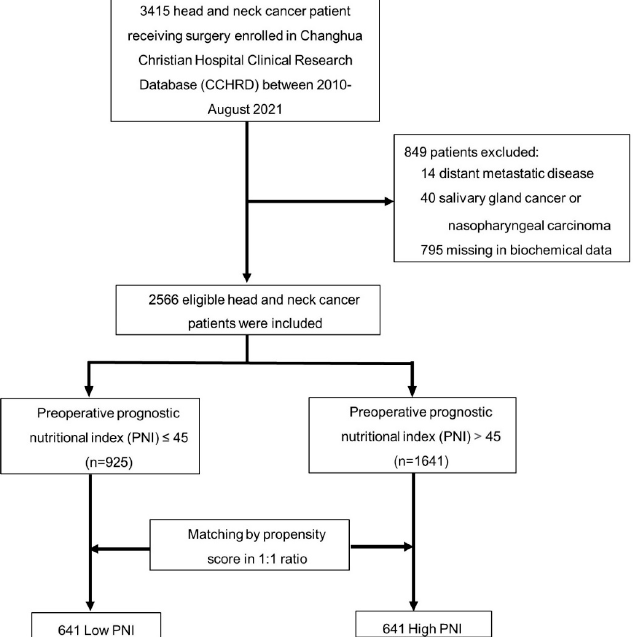
Figure 1. Study Flow chart. A total of 2566 out of 3415 patients were included in this study. Patients were categorized according to PNI score. A multivariate logistic regression analysis and propensity score-matched analysis were performed for the two groups. (PNI = prognostic nutritional index).